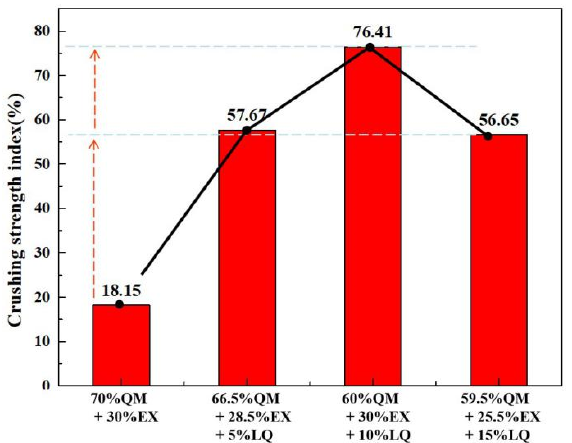
Figure 16. Crushing strength index of ferro-coke with different amounts of coal tar pitch.